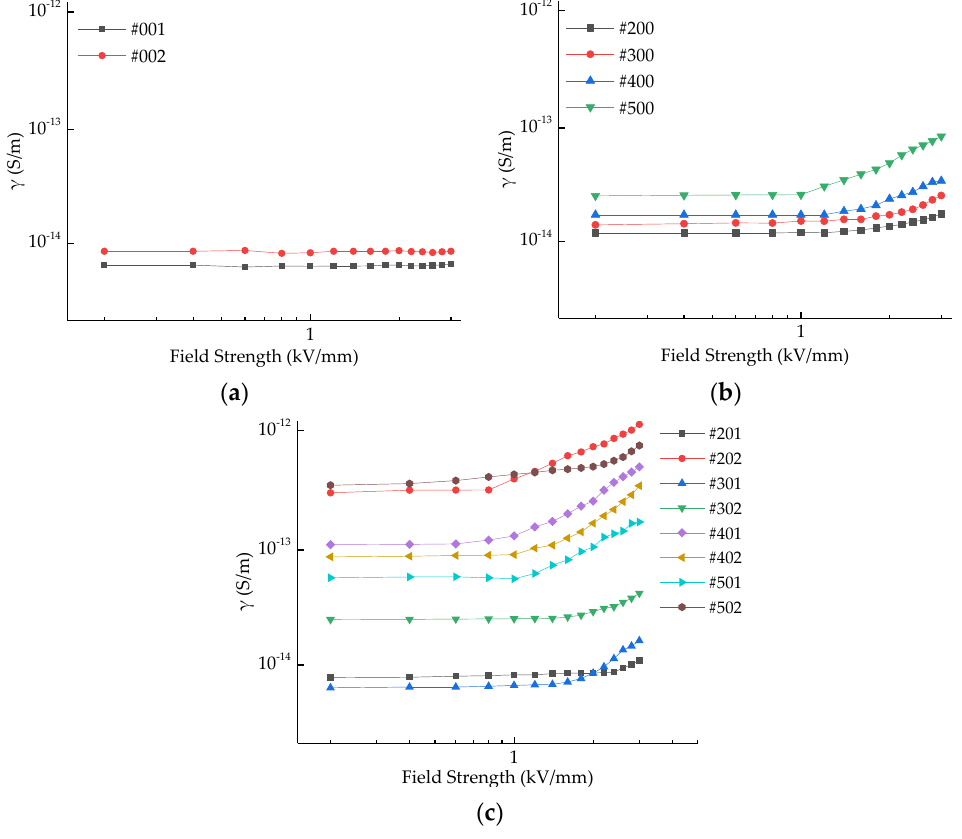
Figure 2. ( a ) The conductivity of nano SiO 2 doped specimen, ( b ) micron SiC/Epoxy composites, and ( c ) nano-micron hybrid composites. ( c ) nano-micron hybrid